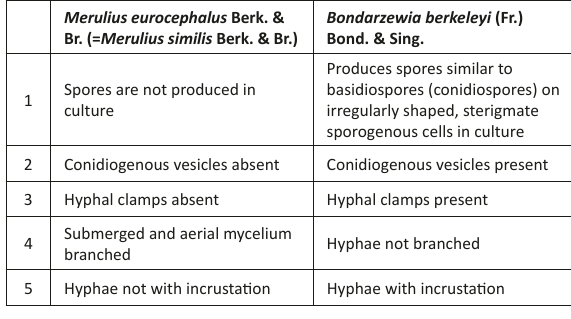
Table 1. Cultural characteristic differences between Merulius eurocephalus Berk. & Br. & Bondarzewia berkeleyi (Fr.) Bond. &